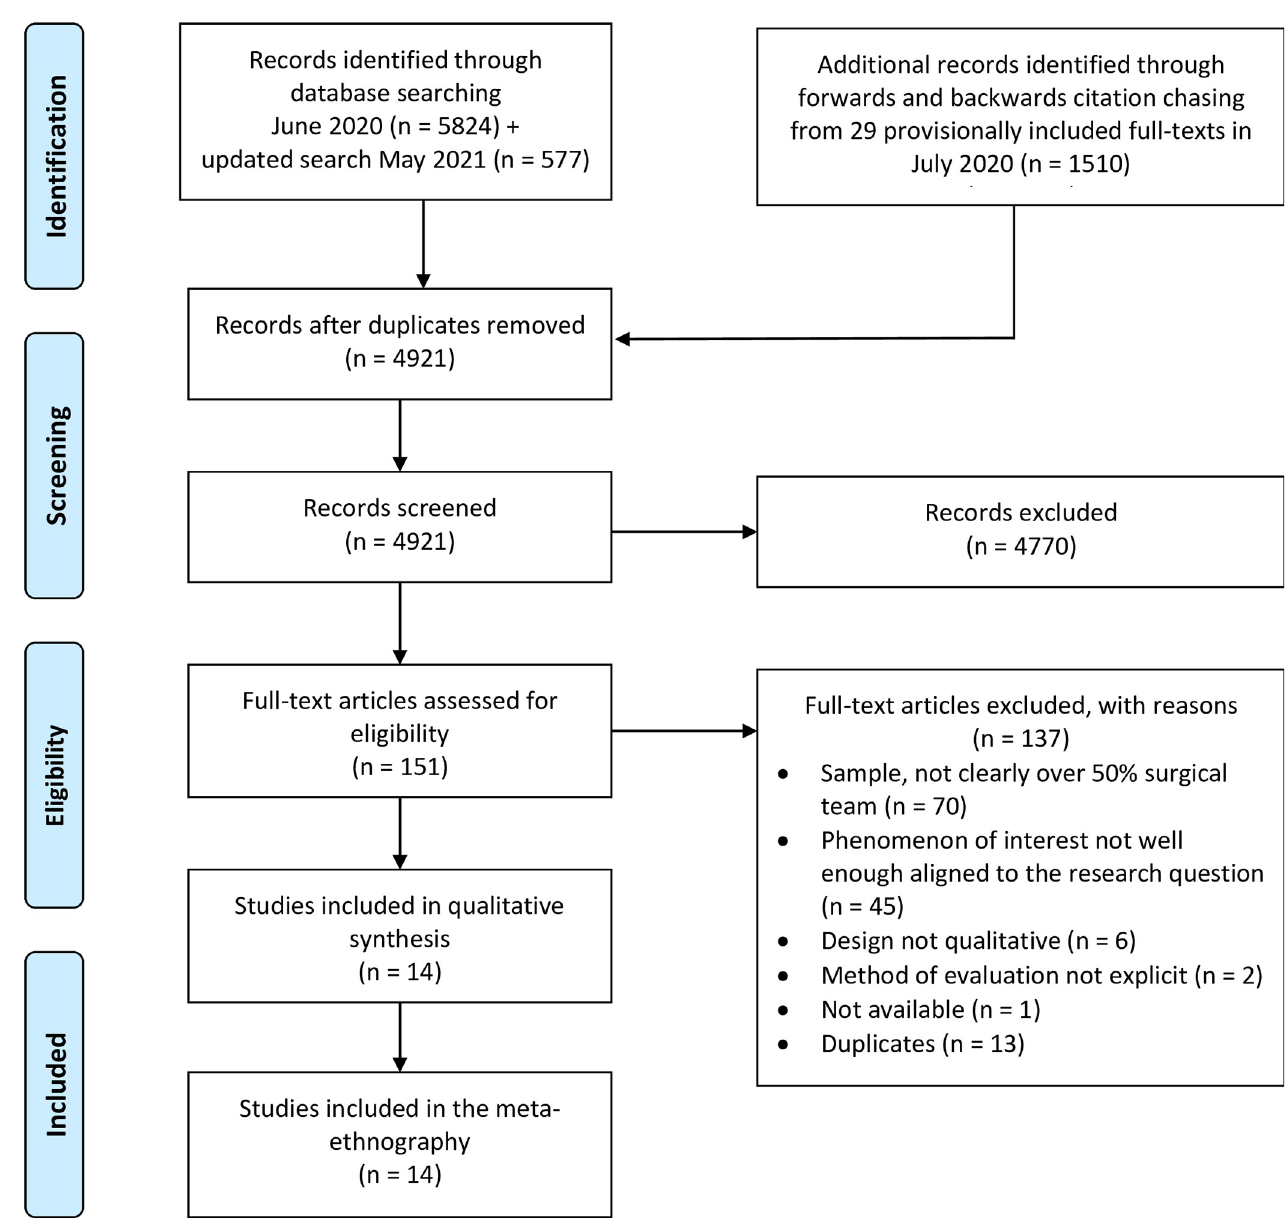
Fig 1. PRISMA diagram outlining the searching and screening process. regulated at a senior level, dependent on the surgical consultant’s preference, as opposed to guideline recommendations [59]. The vertical structure of the surgical team (surgical doctors with different levels of training, experience and responsibility i.e. the consultant, specialist reg- istrar, and more junior trainee doctors) leaves little room or opportunity for input from other team members, particularly during ward rounds [26]. The surgeons, though not fully engaged with the antibiotic decisions made for their patients, remain the leaders in their specialty and engaging with them in antimicrobial stewardship will be tantamount to engaging with their